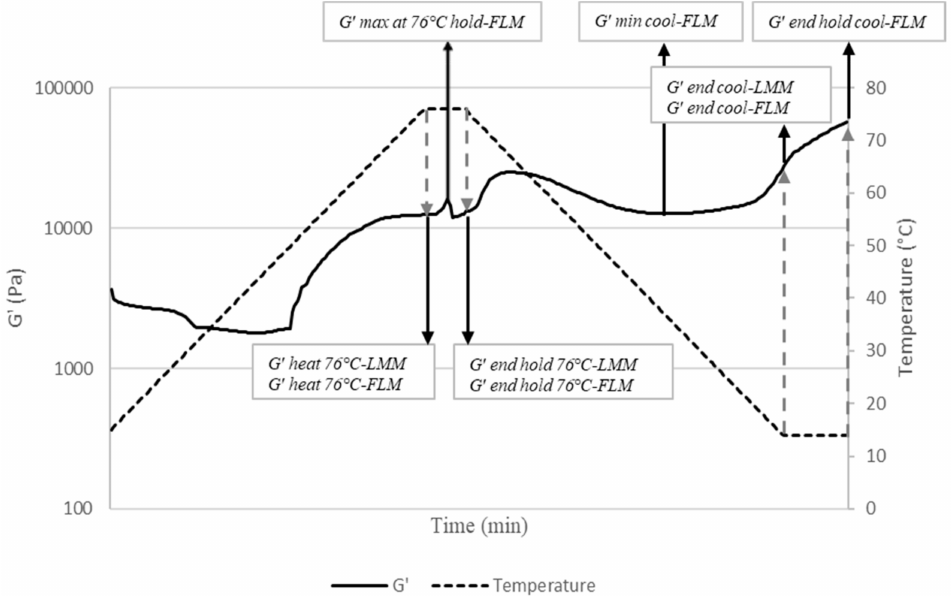
Figure 1. Rheological measurement, composed of a concatenation of temperature ramps and time sweeps, representing thermal process simulation of both LMM and FLM. Simulation starting tem- peratures are 14 ◦ C and 40 ◦ C for LMM and FLM, respectively. Second time sweep step at 14 ◦ C is only executed for FLM. Values of G (cid:48) derived from graph and used as parameters in cluster analysis include: G (cid:48) heat 76 ◦ C-LMM and G (cid:48) heat 76 ◦ C-FLM referring to G (cid:48) at end of first temperature ramp (76 ◦ C) for both model systems; G (cid:48) max at 76 ◦ C hold-FLM referring to maximum measured value of G (cid:48) during first time sweep (76 ◦ C) of FLM; G (cid:48) end hold 76 ◦ C-LMM and G (cid:48) end hold 76 ◦ C-FLM referring to G (cid:48) at end of first time sweep (76 ◦ C) for both model systems; G (cid:48) min cool-FLM referring to minimum value of G (cid:48) during second temperature ramp of FLM; G (cid:48) end cool-LMM and G (cid:48) end cool-FLM referring to G (cid:48) at end of second temperature ramp (14 ◦ C) for both model systems; G (cid:48) end hold cool-FLM referring to G (cid:48) at end of second time sweep (14 ◦ C) of